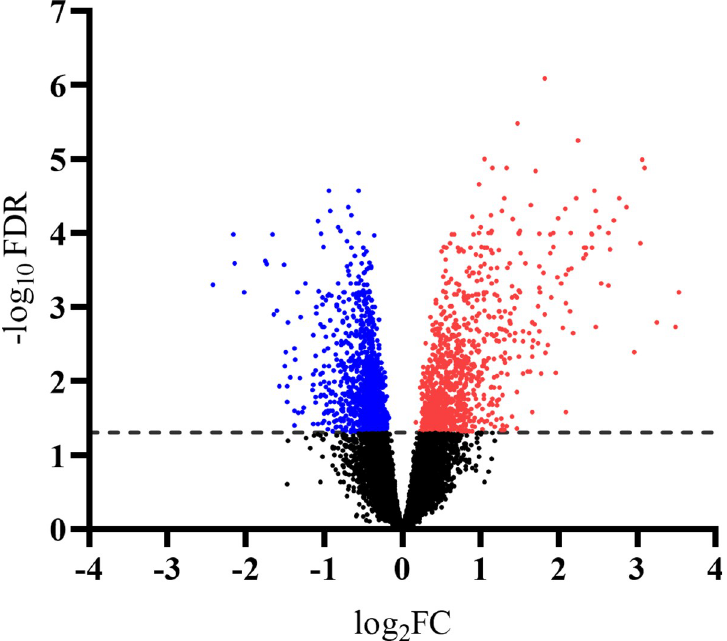
Fig 3. Volcano plot representing the differently expressed genes due to the main effect of time (pre- vs. post- vaccination). A total of 2,396 genes were differently expressed after vaccination (d 201 vs. d 154). The cutoff for DEG was considered at FDR � 0.05, as indicated by the dash line. The y-axis is the -log 10 FDR while the x-axis represents the log 2 FC. Each dot represents a gene. Blue dots indicate downregulated genes, red dots indicate upregulated genes, and black dots indicate non-differentially expressed genes on d 201.